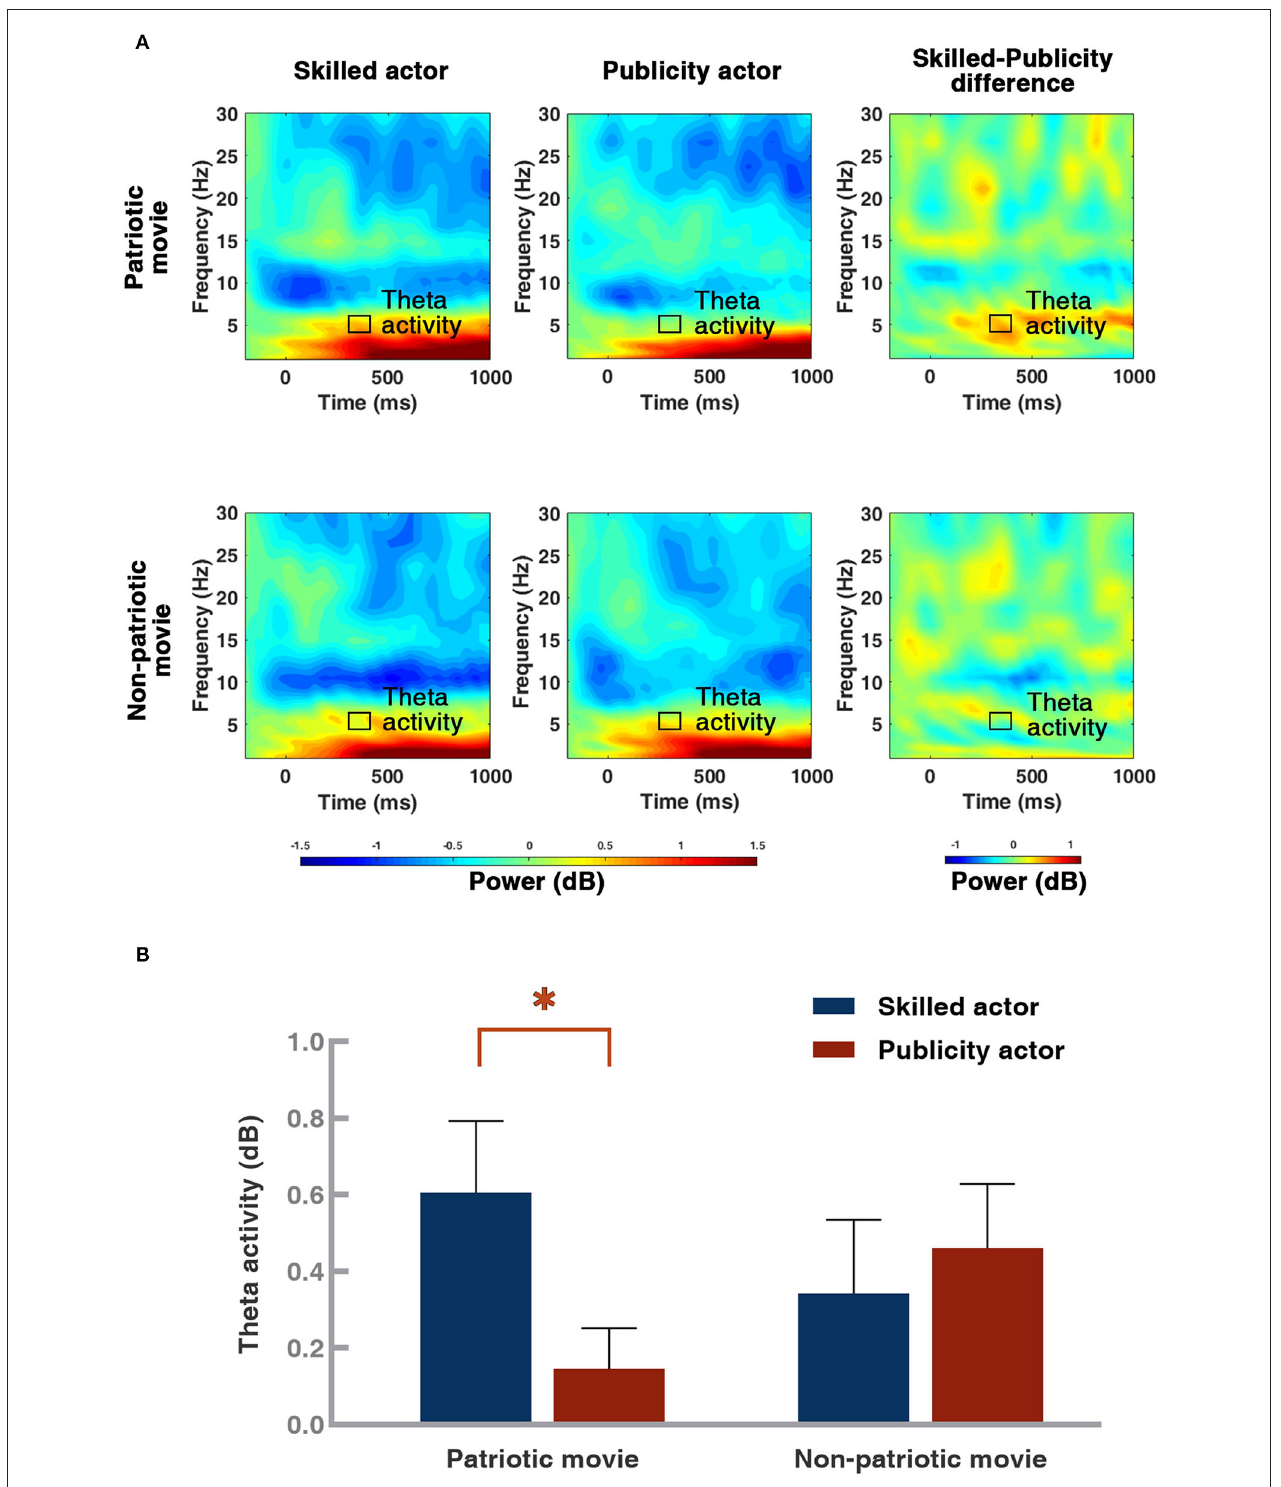
FIGURE 6 | Illustration of neural oscillation at Fz and theta ERS results. (A) Illustration of grand-averaged neural oscillation at Fz under four conditions and skilled/publicity difference. (B) Averaged magnitude of theta activity from Fz (frequency range = 4.1–5.8Hz, time range = 330–380ms) under four conditions. Theta band (4–7Hz) activity from 330 to 380ms, with a frequency range of 4.08–5.80Hz, was selected (the black box area). In the graphs, the shade of the color represents the strength of the power. The darker the color was, the stronger was the power. Error bar: standard error, * p < 0.05.